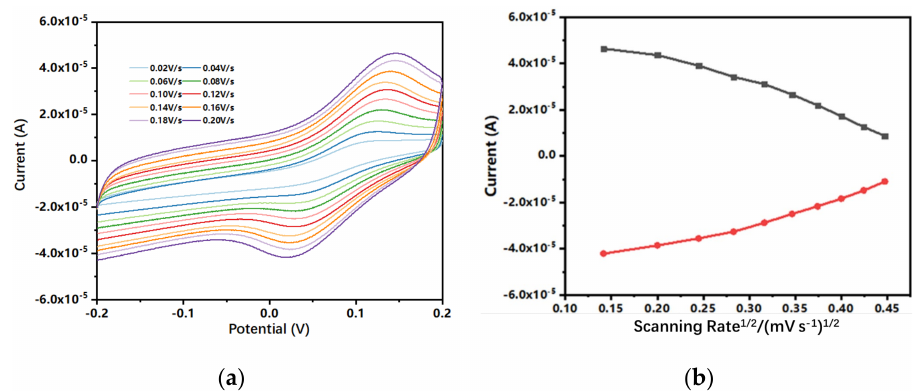
Figure 2. ( a ) Cyclic voltammograms of 0.5 mM ferrocene carboxylic acid in 0.1 M KCl (containing 5 mM [Fe(CN) 6 ] 3-/4- ) at different scanning rates: 20, 40, 60, 80, 100, 120, 140, 160, 180, and 200 mV/s. ( b ) Calibration plots of the anodic (I pa ) and cathodic peak current (I pc ) versus the square of the scanning rate.